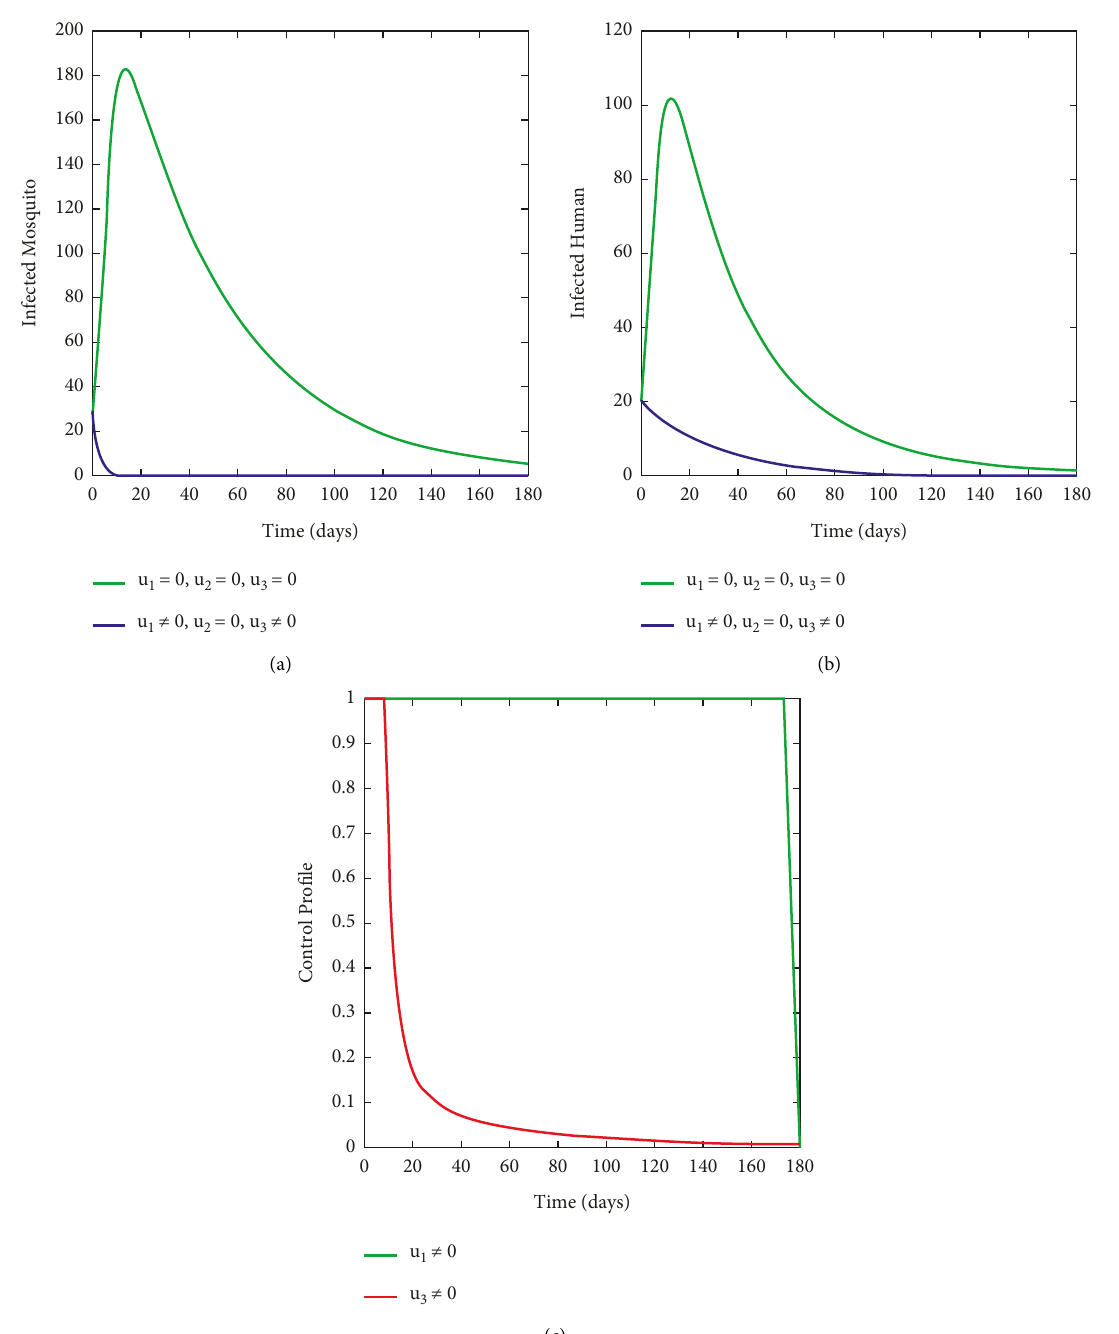
Figure 3: Simulation results depicting the use of (a) treatment of infectives ( u , u ≠ profile u 1 3